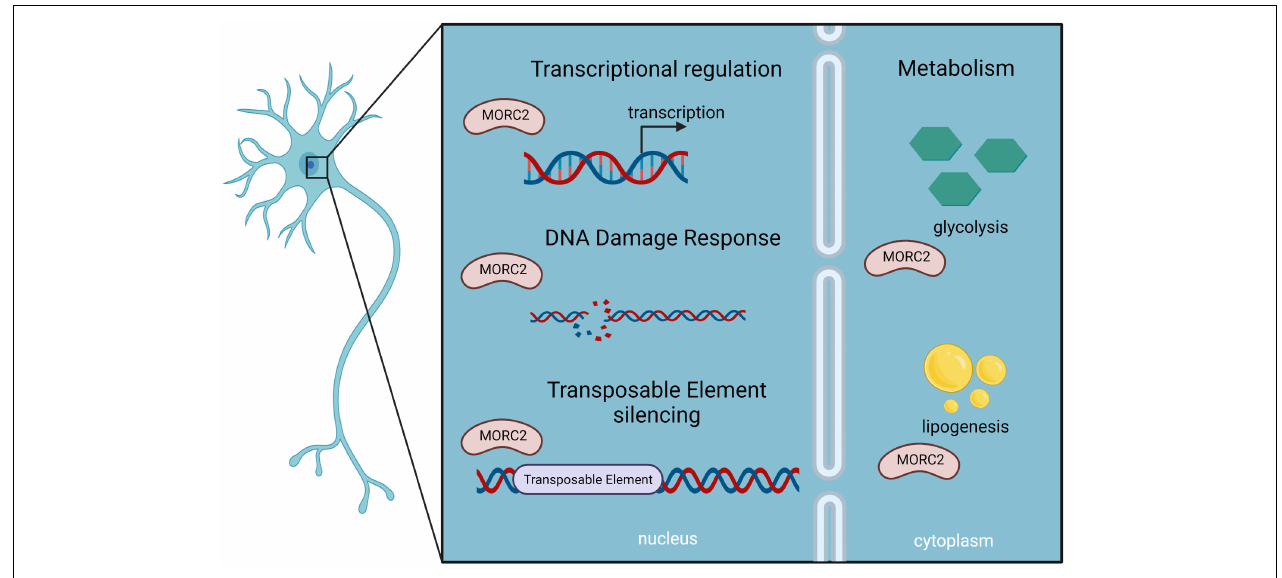
FIGURE 7 | Schematic representation of MORC2 functions as described in neurons, which could be implicated in MORC2-related